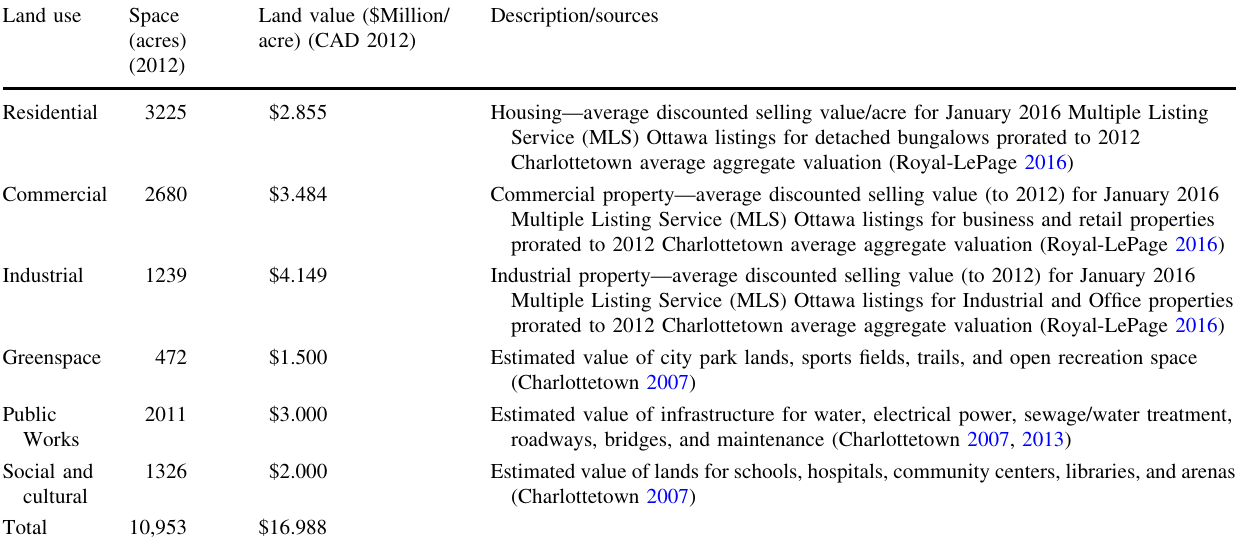
Table 2 City of Charlottetown, Prince Edward Island, attributed land value assets Land